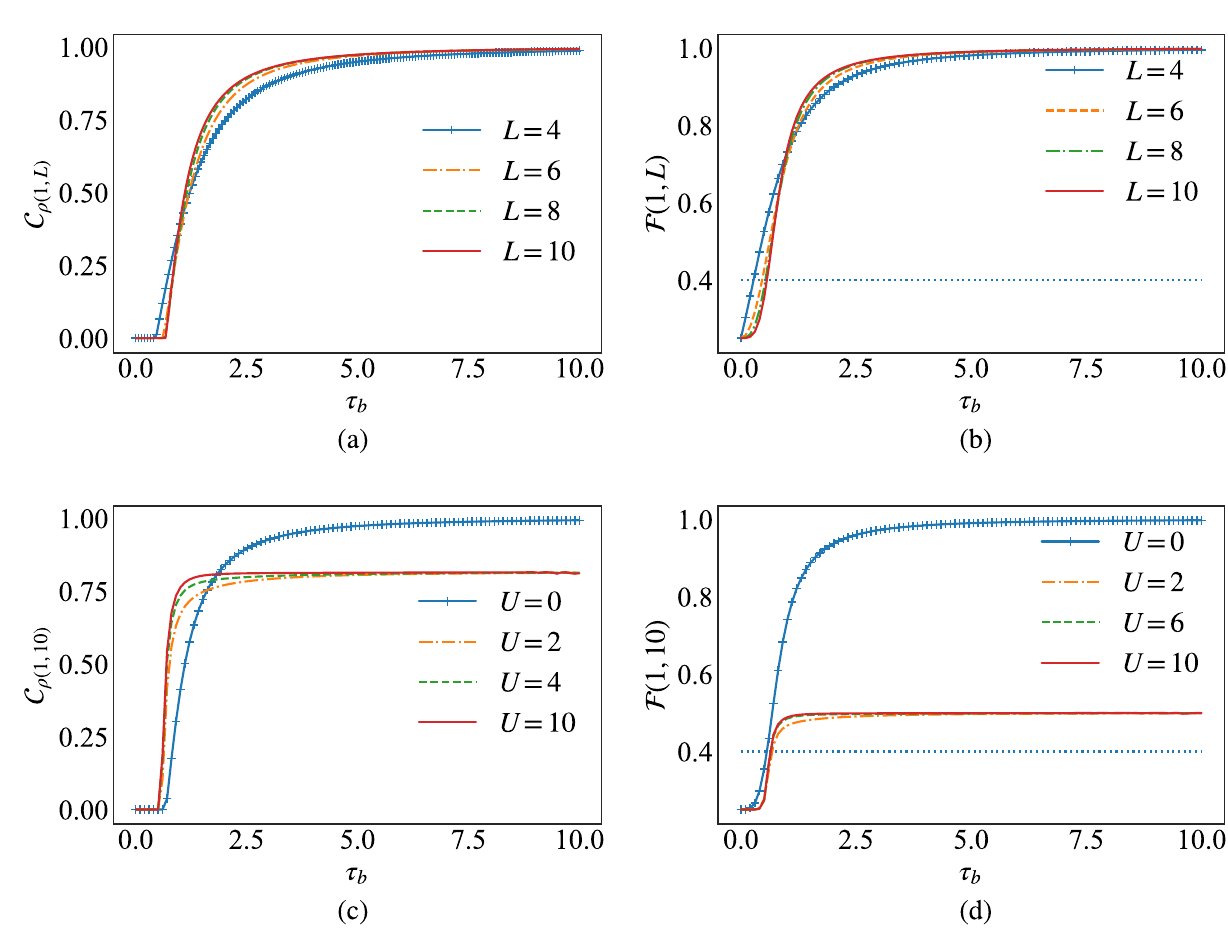
Figure 5. ( a )+( b ) The end-to-end concurrence, Eq. (13), and fidelity, Eq. (9), respectively, with respect to τ b for several chain sizes L . ( c )+( d ) The same functions for different values of U and fixed chain length L